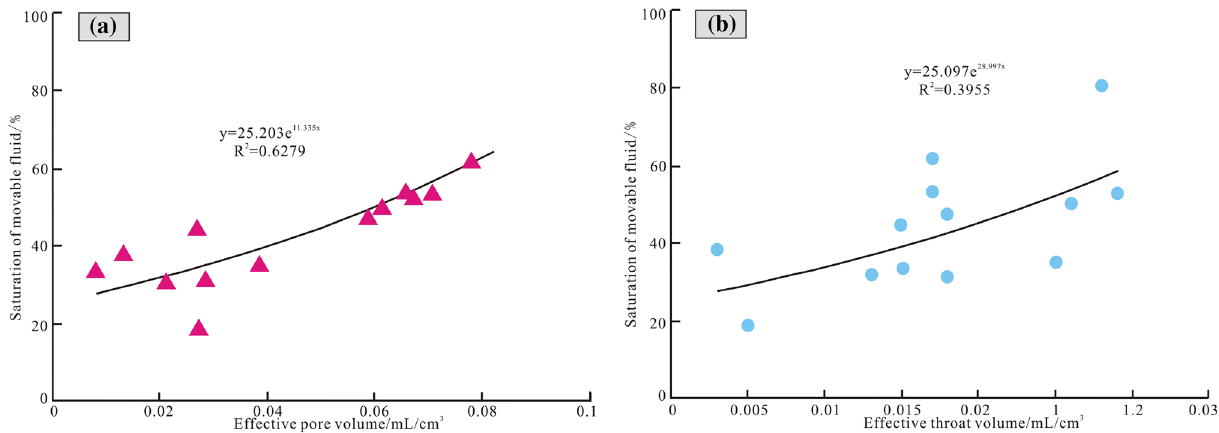
Fig. 7 Relationship between effective pore and throat volumes and movable fluid saturation in Chang 8